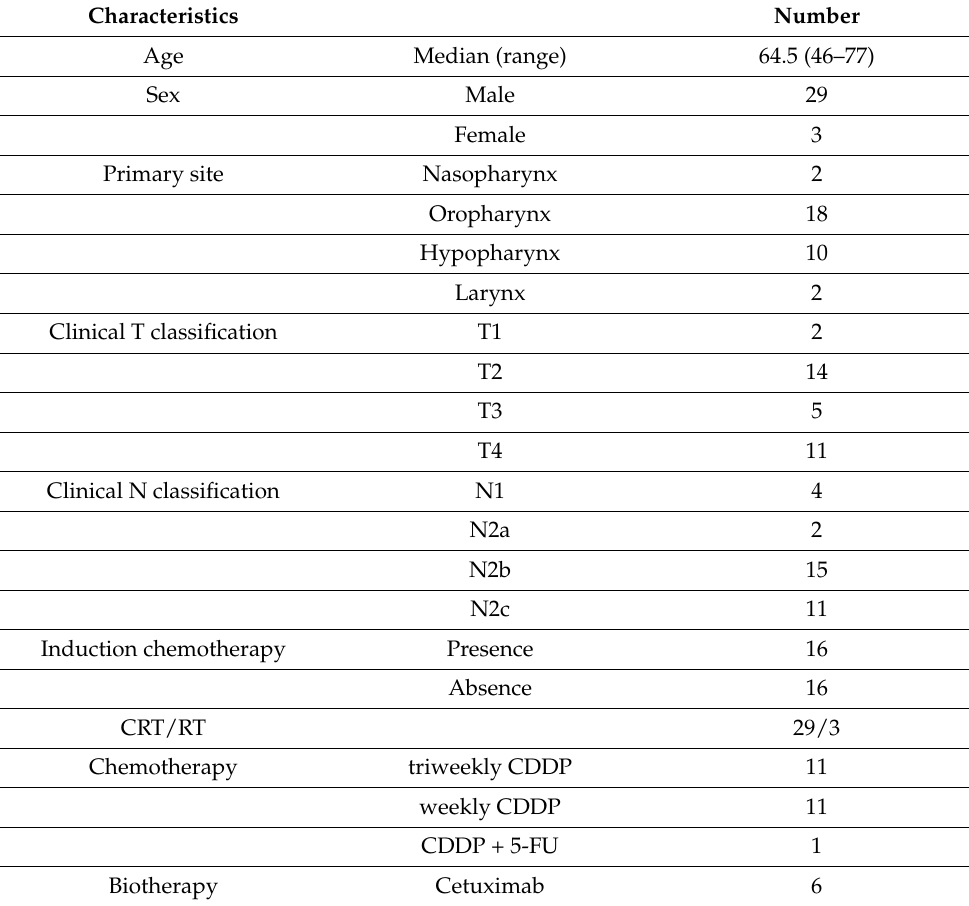
Table 1. Patient characteristics ( n =